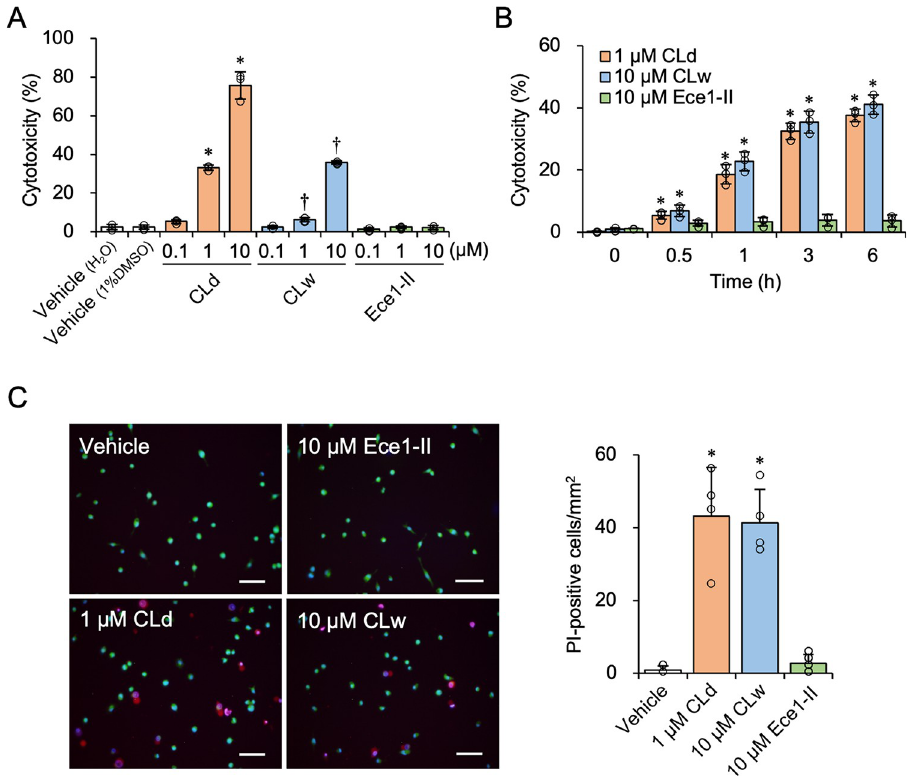
Fig 2. Cytotoxicity of CLd and CLw in differentiated THP-1 cells. A: Cells were treated with varied concentrations of CLd, CLw, or Ece1-II for 3 h. The vehicle controls for CLd and CLw are a medium containing 1% DMSO and a water-added medium (H 2 O), respectively. Cytotoxicity was quantified by a LDH release assay. Data are presented as the mean ± SD (n = 3) and are representative of three independent experiments. � P < 0.05 compared with the vehicle (1% DMSO; μ c < μ i); † P < 0.05 compared with the vehicle (H 2 O; μ c < μ i) by one-way ANOVA followed by Dunnett’s test. B: Cells were treated with 1 μ M CLd, 10 μ M CLw, or 10 μ M Ece1-II for the indicated period (0 − 6 h). Cytotoxicity was quantified by an LDH release assay. Data are presented as the mean ± SD (n = 3) and are representative of three independent experiments. � P < 0.05 compared with 0 h by one-way ANOVA followed by Dunnett’s test ( μ c < μ i). C: Cells were treated with 1 μ M CLd, 10 μ M CLw, or 10 μ M Ece1-II for 3 h, followed by staining with PI (red, indicative of damaged cells), Calcein-AM (green, indicative of live cells), and Hoechst 33342 (blue, all cells). The vehicle control is a medium containing 1% DMSO. Fluorescence images were taken with a fluorescence microscope at 100 × magnification. Scale bars, 100 μ m. Quantified data (the number/mm 2 of PI-positive cells) are presented as the mean ± SD (n = 4) and are representative of three independent experiments. � P < 0.05 compared with the vehicle by one-way ANOVA followed by Dunnett’s test ( μ c < μ i).